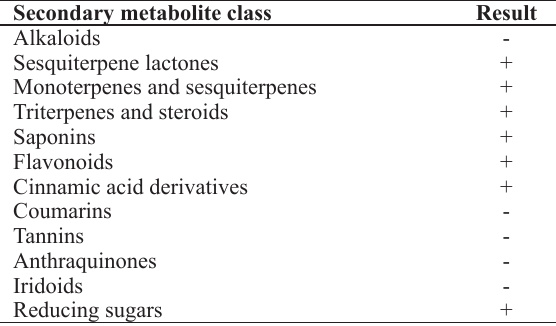
Phytochemical profile of leaves of Solidago